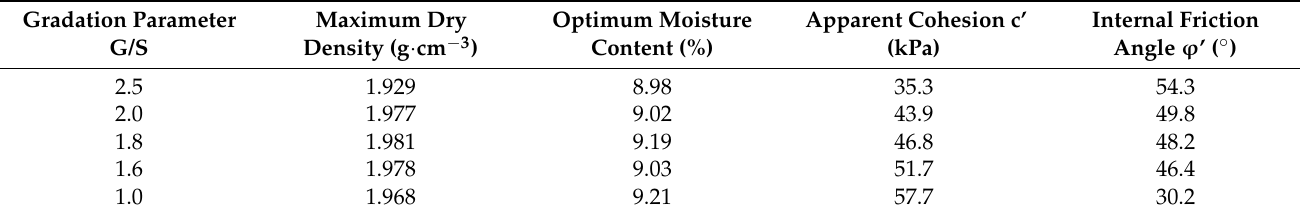
Table 5. The laboratory compaction and shear strength properties of recycled BDW aggregates with five different